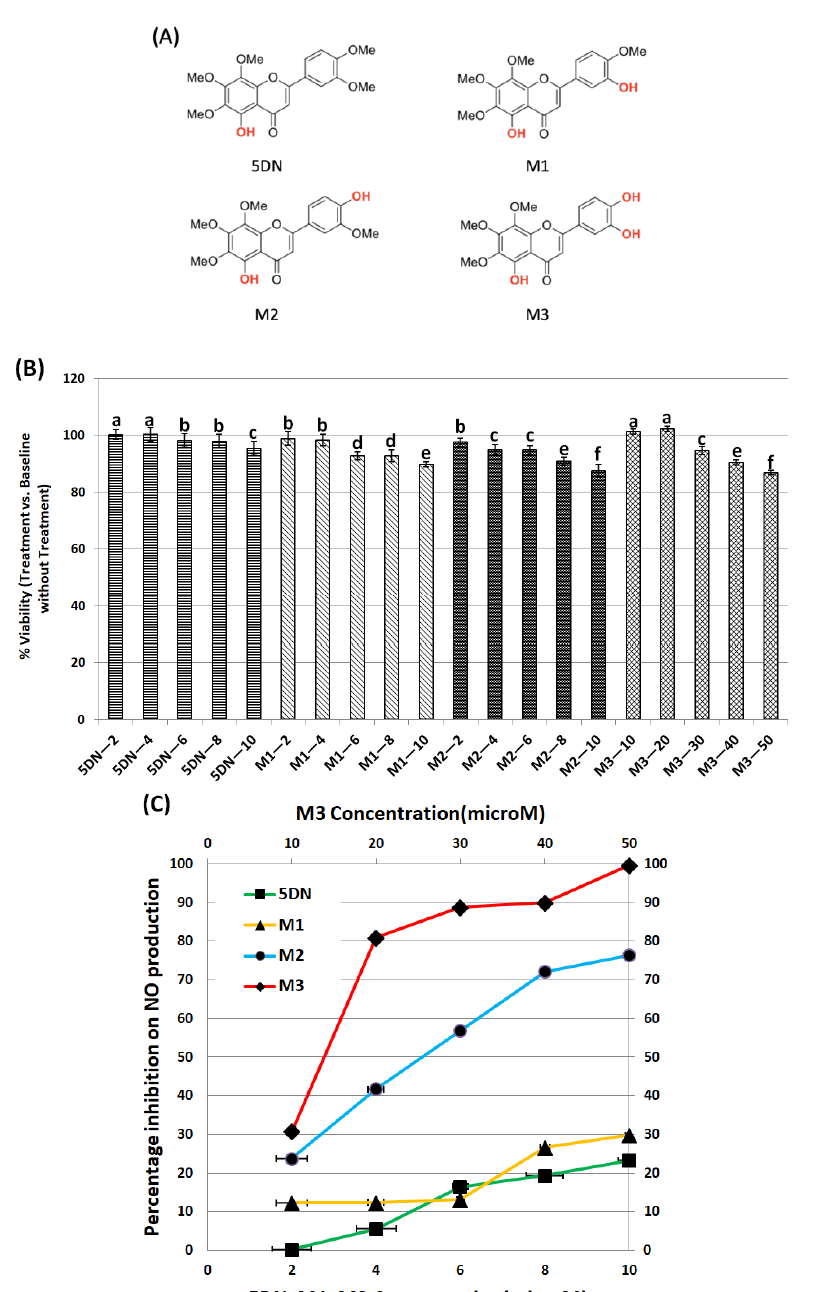
Figure 1. Inhibitory effects of 5DN and its metabolites M1, M2, and M3 on LPS-induced NO production within nontoxic dose ranges in RAW 264.7 cells. ( A ) The structures of 5DN and its metabolites M1, M2, and M3. ( B ) Cytotoxicity profiles of 5DN and its metabolites M1, M2, and M3 in RAW 264.7 macrophage cells. The viability of control cells was set as the reference with a value of 100%. Results are presented as mean ± SD (n = 6). Different superscript letters in each column indicate significant differences between groups ( p < 0.05, n = 6) by one-way ANOVA and Tukey’s post hoc test. ( C ) Percentage of inhibition on NO production by 5DN and its metabolites M1, M2, and M3 in LPS-stimulated RAW 264.7 cells. The cells were treated with LPS (positive control) or LPS plus serial concentrations of 5DN and its metabolites M1, M2, and M3, as indicated in the bar graph. After 24 h of incubation, the culture media were collected for NO assay, as described in the Method section. Results are presented as mean ± SD. All treatments showed statistical significance in comparison with the positive control ( p < 0.01, n = 6).